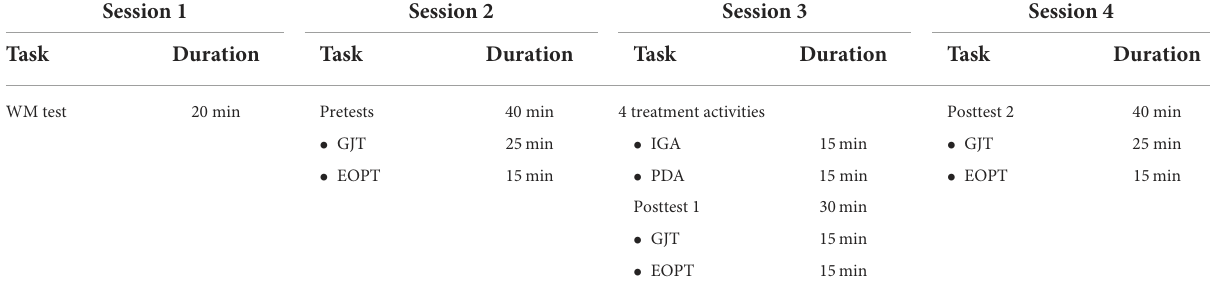
TABLE 3 Procedure of the study.